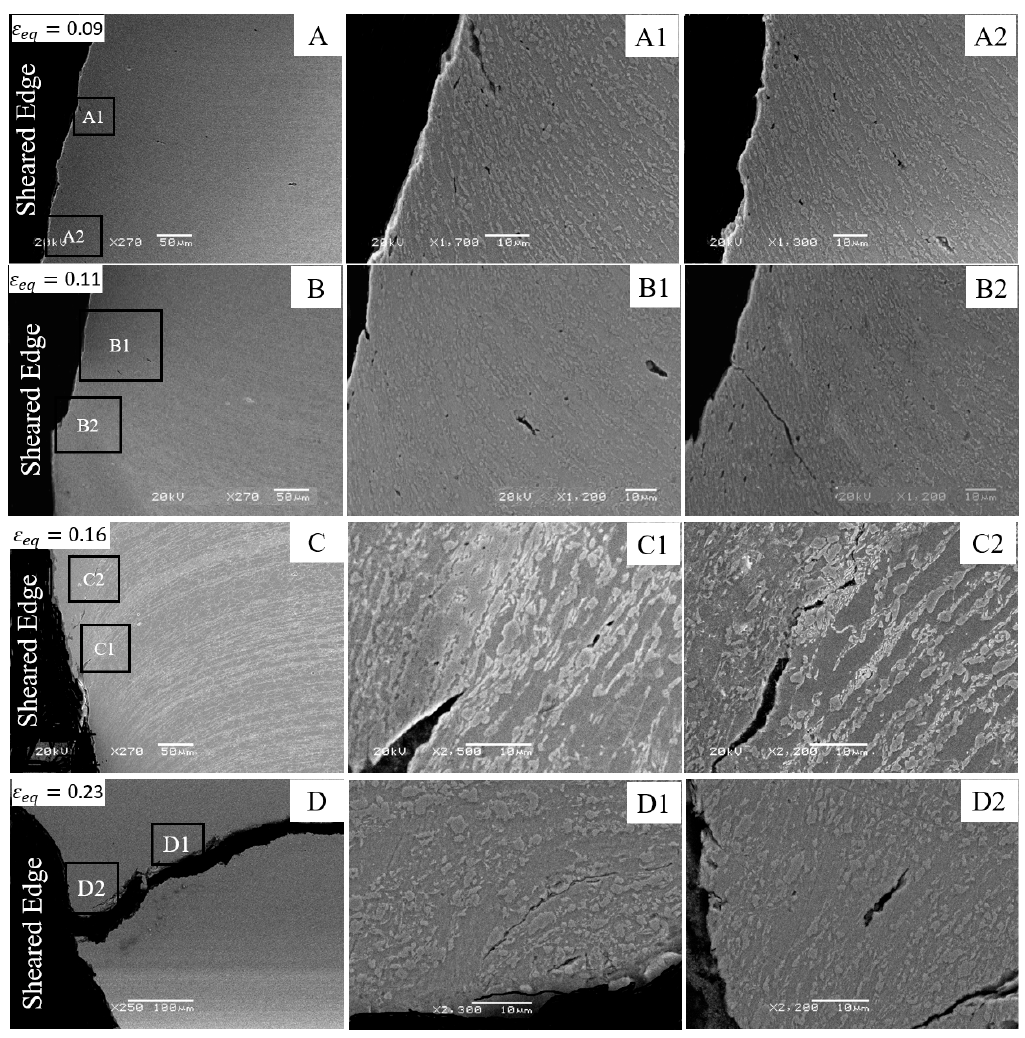
Figure 12. SEM micrographs of the interrupted DP780 sheared edge hole tension specimens at different strain levels: ( A ) 0.09; ( B ) 0.11; ( C ) 0.16; and ( D )